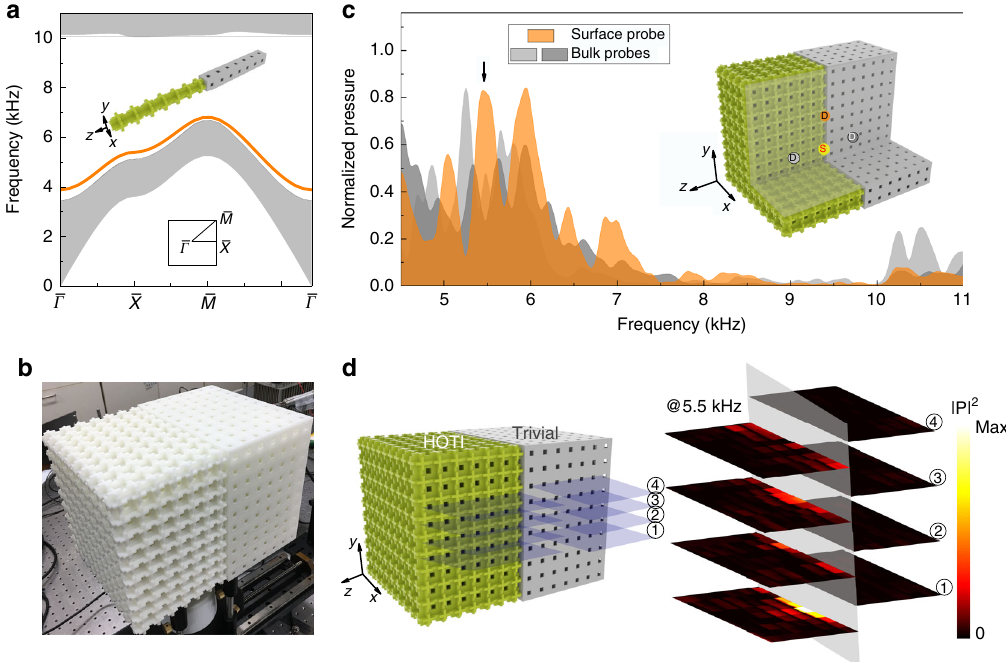
Fig. 2 Topological surface states: boundary with codimension one. a Calculated band structures of the bulk (gray) and surface (orange) states for the supercell with a surface boundary in the x – y plane between the topological and trivial SCs (see the inset). Surface Brillouin zone is shown in the inset. b Photograph of the fabricated surface sample, consisting of the topological and trivial SCs to form a surface boundary. c Measured transmission spectra for three types of pump – probe con fi gurations denoted as the bulk and surface probes. As depicted in the inset, the source is placed on the surface. Two bulk probes are placed in the topological and trivial SC sides, respectively, while the surface probe is placed on the surface away from the source. d Acoustic pressure pro fi le for the surface states measured at the excitation frequency of 5.5 kHz (indicated in c by the black arrow) using slice plots. The positions of the slices are depicted in the fi gure as